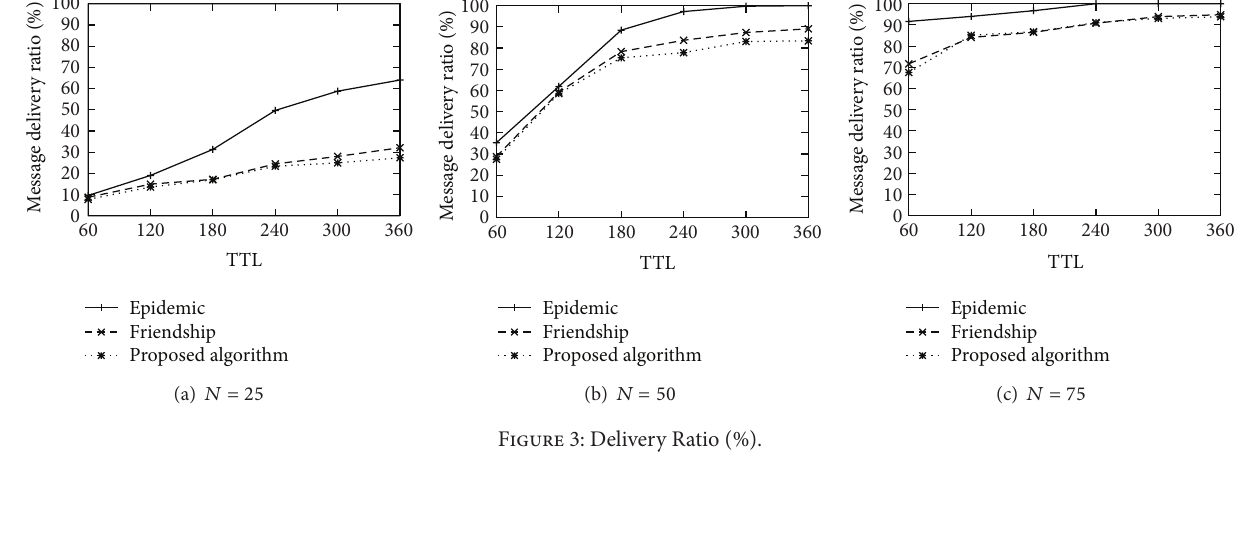
Figure 3: Delivery Ratio (%).